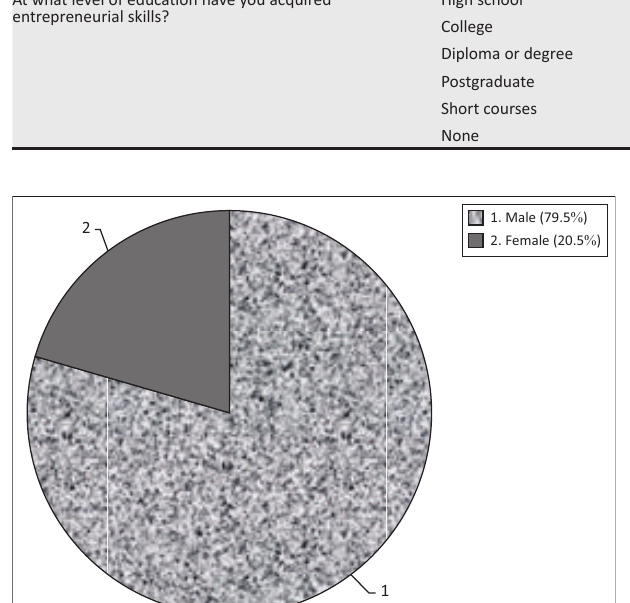
FIGURE 1: Gender analysis of respondents.